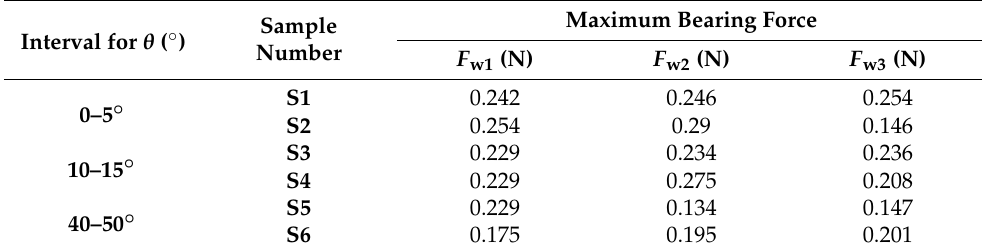
Table 6. Results of bearing capacity measurement for electrode wires. Interval for θ ( ◦ )